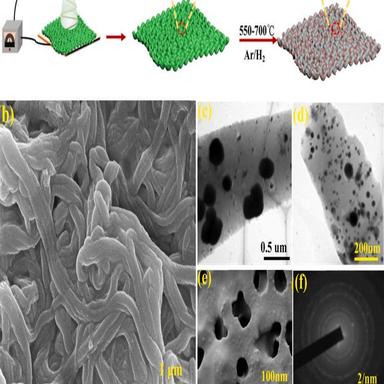
(a) Schematic diagram of the fabrication of the composite Sn/Sb@SSO@PCFs structure process. (b) SEM images for the obtained Sn/Sb@SSO@PCFs fibers. (c-d) LRTEM images for the Sn/Sb@SSO@PCFs at varied magnification. (e)Porous structure appearing on the surface of carbon fibers. (f) SAED patterns of the Sn/Sb@SSO@PCFs.